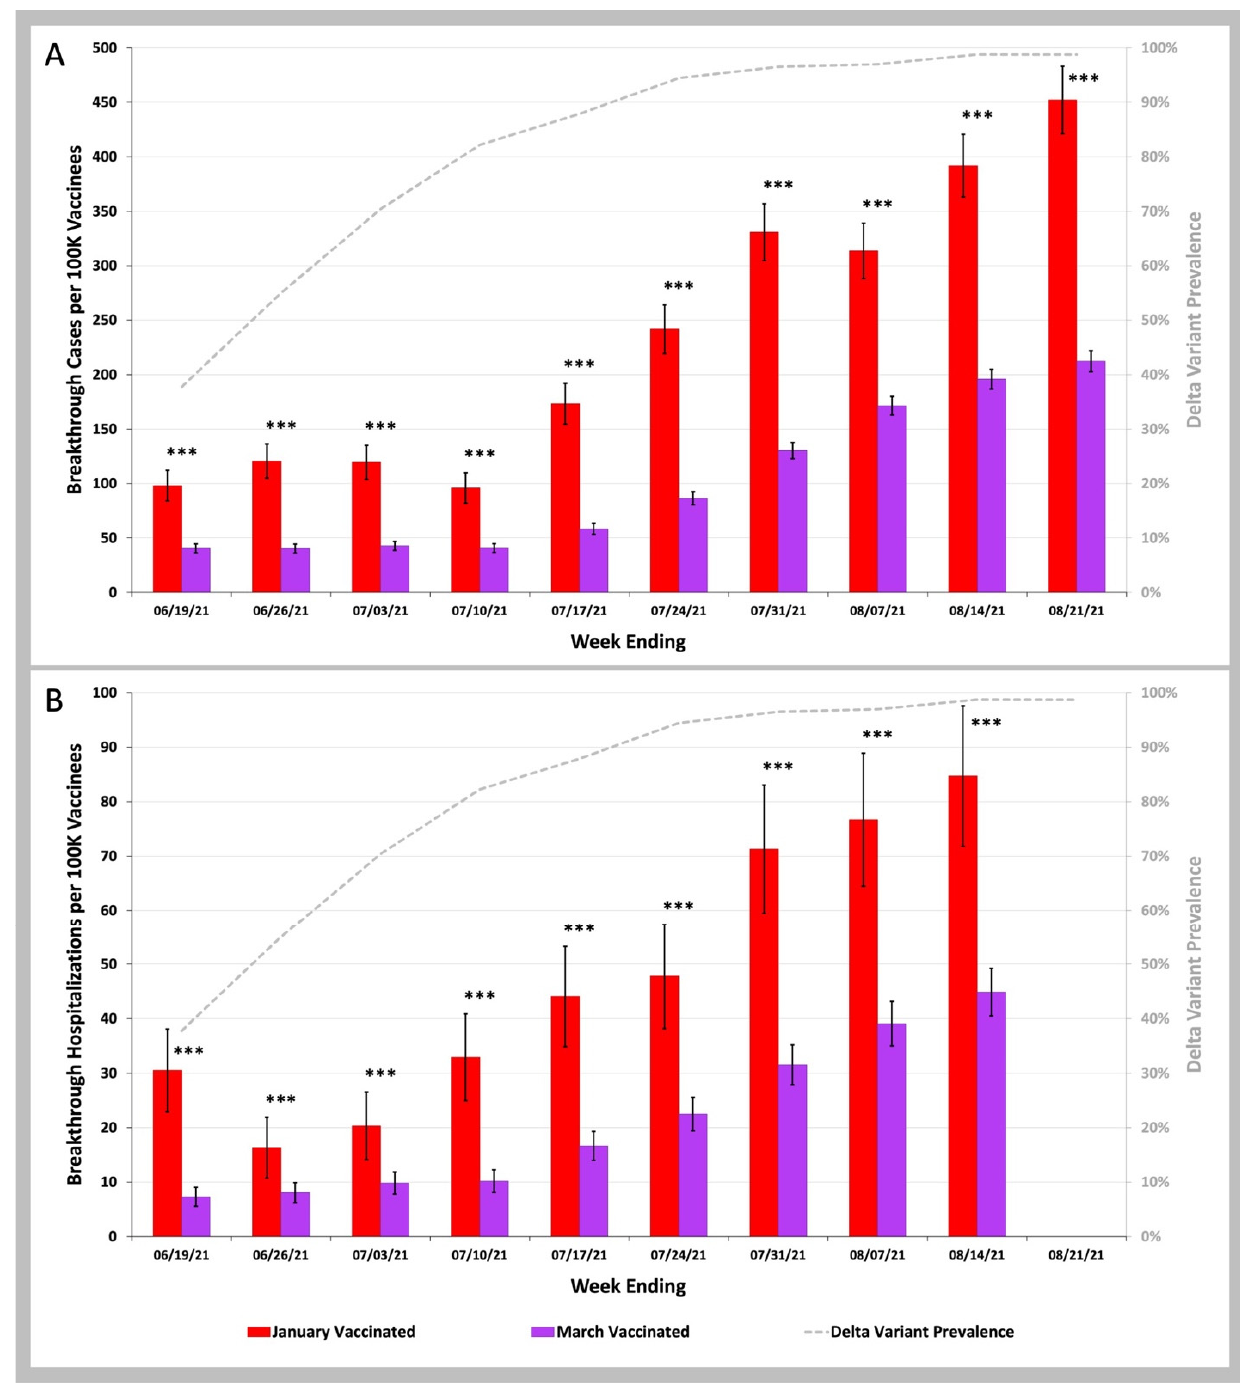
Figure 3. COVID-19 Breakthrough Infection and Hospitalization Rates in Individuals Vaccinated in January versus March 2021. ( A )—Weekly infection rates per 100 K individuals vaccinated in January 2021 (red bars) vs. vaccinated in March 2021 (purple bars). ( B )—Weekly hospitalization rates per 100 K individuals vaccinated in January 2021 (red bars) vs. vaccinated in March 2021 (purple bars). Weekly SARS-CoV-2 variant prevalence reported by the CDC (gray dashed line). Error bars indicate 95% CI. Asterisks shown above the bars indicate p values for weekly rates for those vaccinated in January 2021 being greater than weekly rates for those vaccinated in March 2021. *** p < 0.001 by two-proportion Z-test.